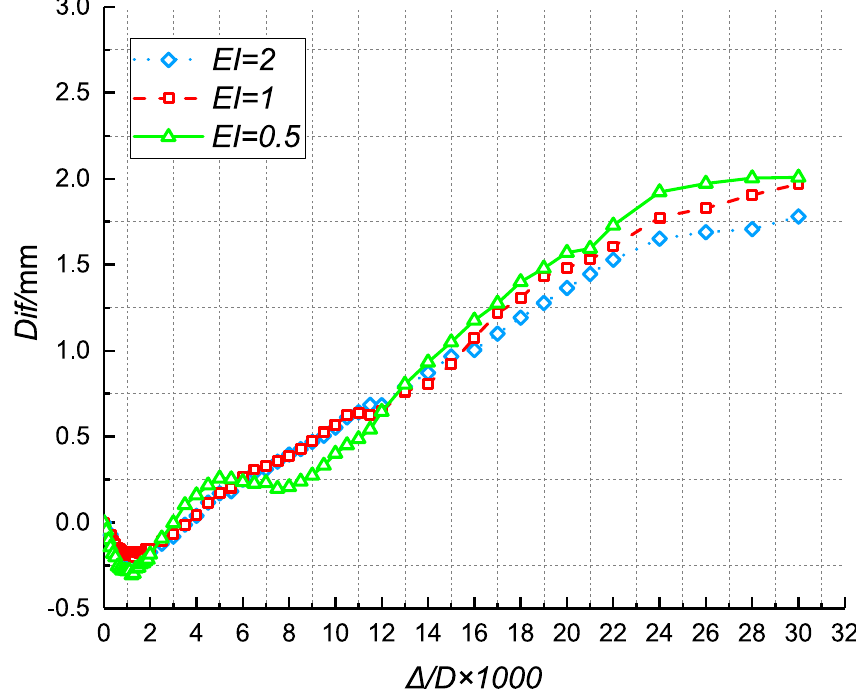
Figure 14. The gap between the pipe roof vertical displacement and the corresponding ground surface